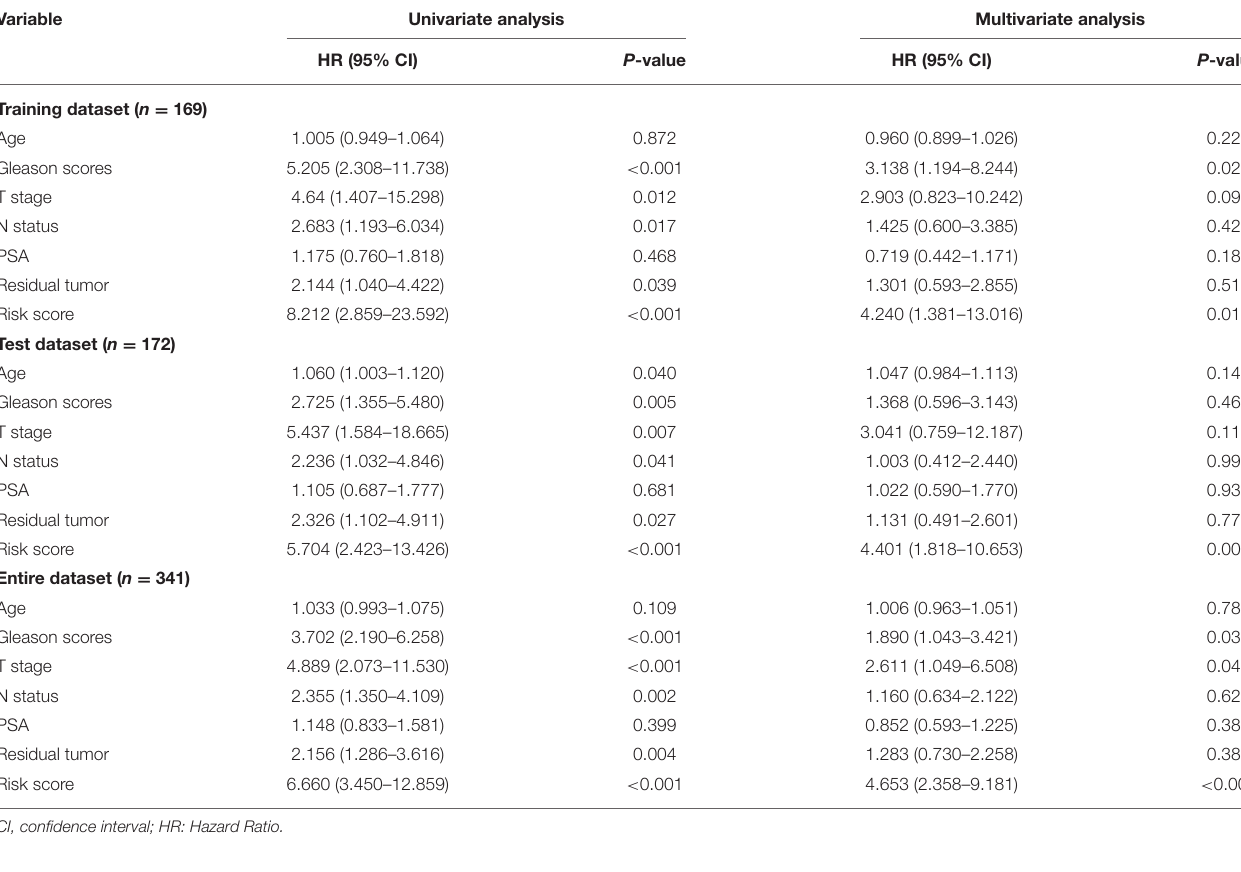
TABLE 1 | Univariate and multivariate analysis of different prognostic parameters in patients with prostate cancer by cox regression analysis.